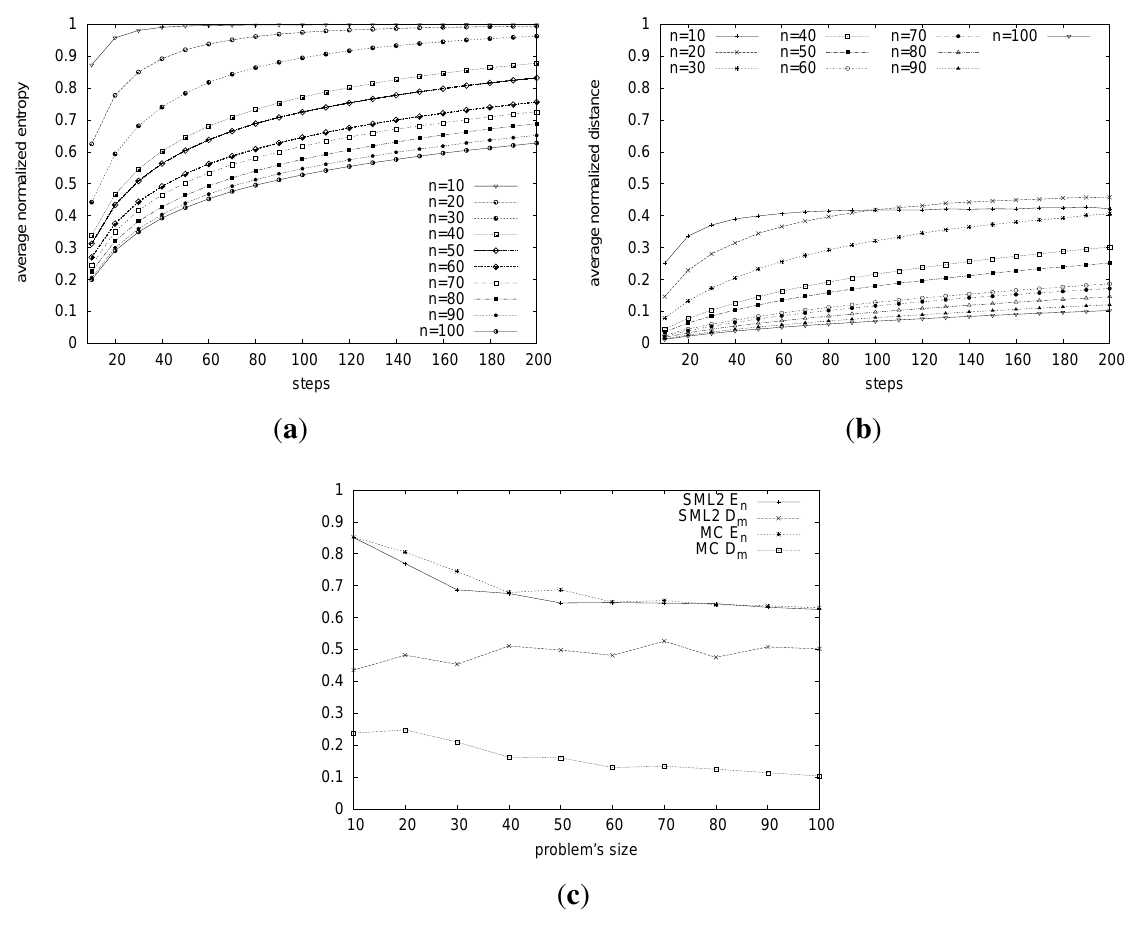
Figure 4. Average runtime entropy of a Markov chain (MC) ( a ); average runtime distance from the male-optimal one of the MC ( b ); local search vs. MC in terms of entropy and distance from the male-optimal one ( c